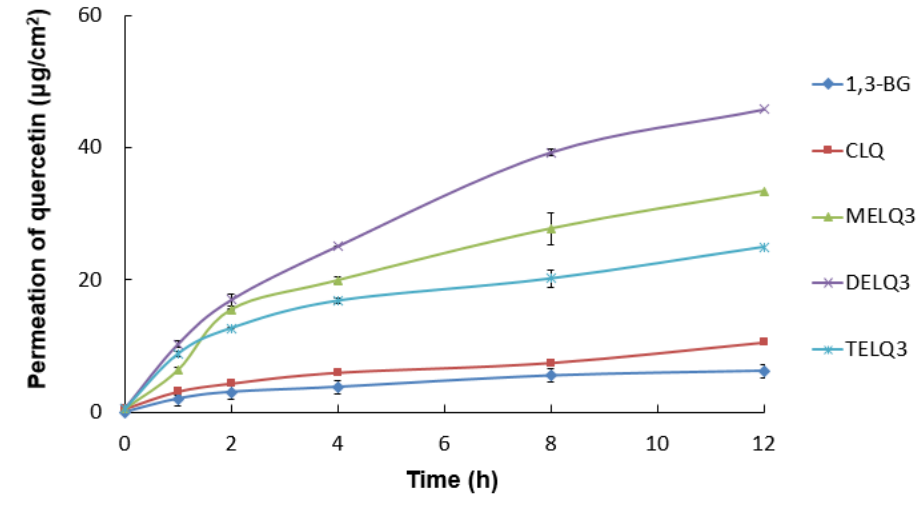
Figure 5. In vitro skin permeation profiles of 1,3-butylene glycol solution (1,3-BG), conventional nanoliposome (CLQ) and elastic nanoliposomes (MELQ3, DELQ3, and TELQ3) though Human skin for 12 h.